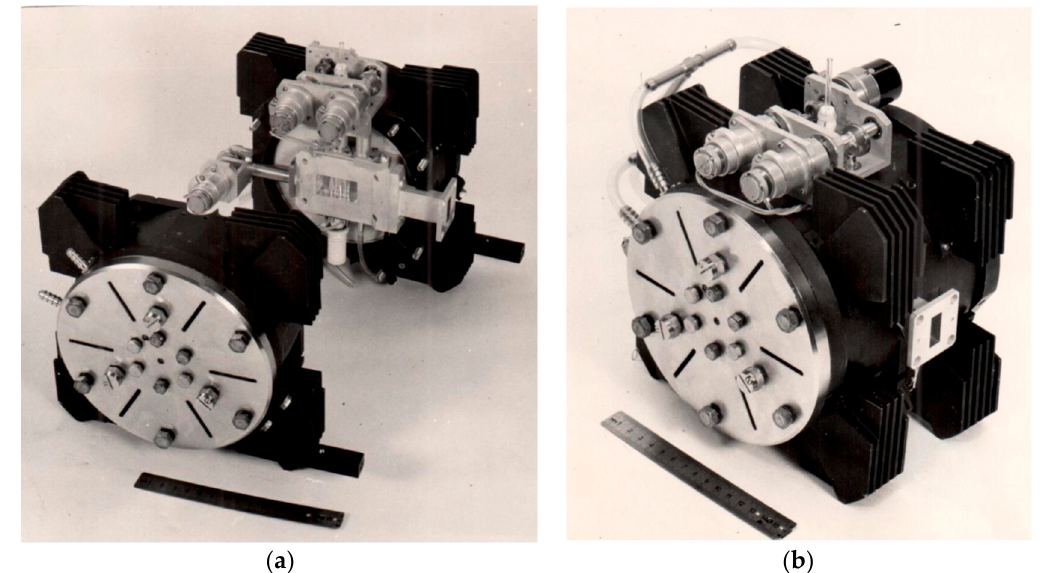
Figure 2. EPR resonator combined with the synchronous detector, dismantled ( a ) and assembled ( b ). Source: Personal archive of V.N.